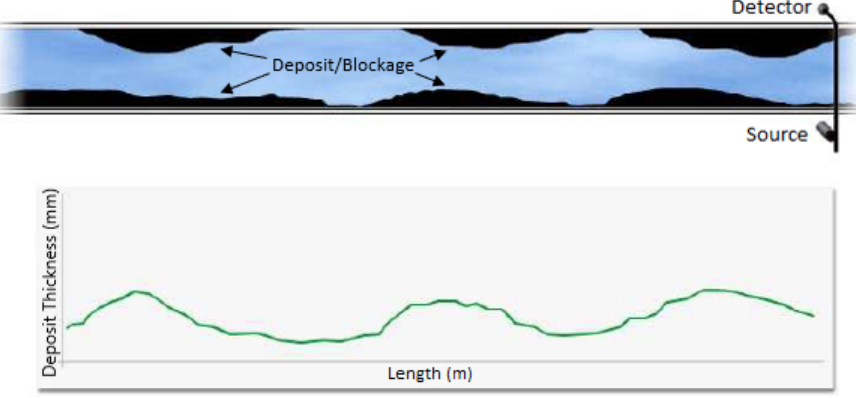
Figure 52. The setup for blockage inspection of a pipeline based on gamma-ray transmission and the corresponding measured blockage profile. Reprinted under Creative Commons CC BY license